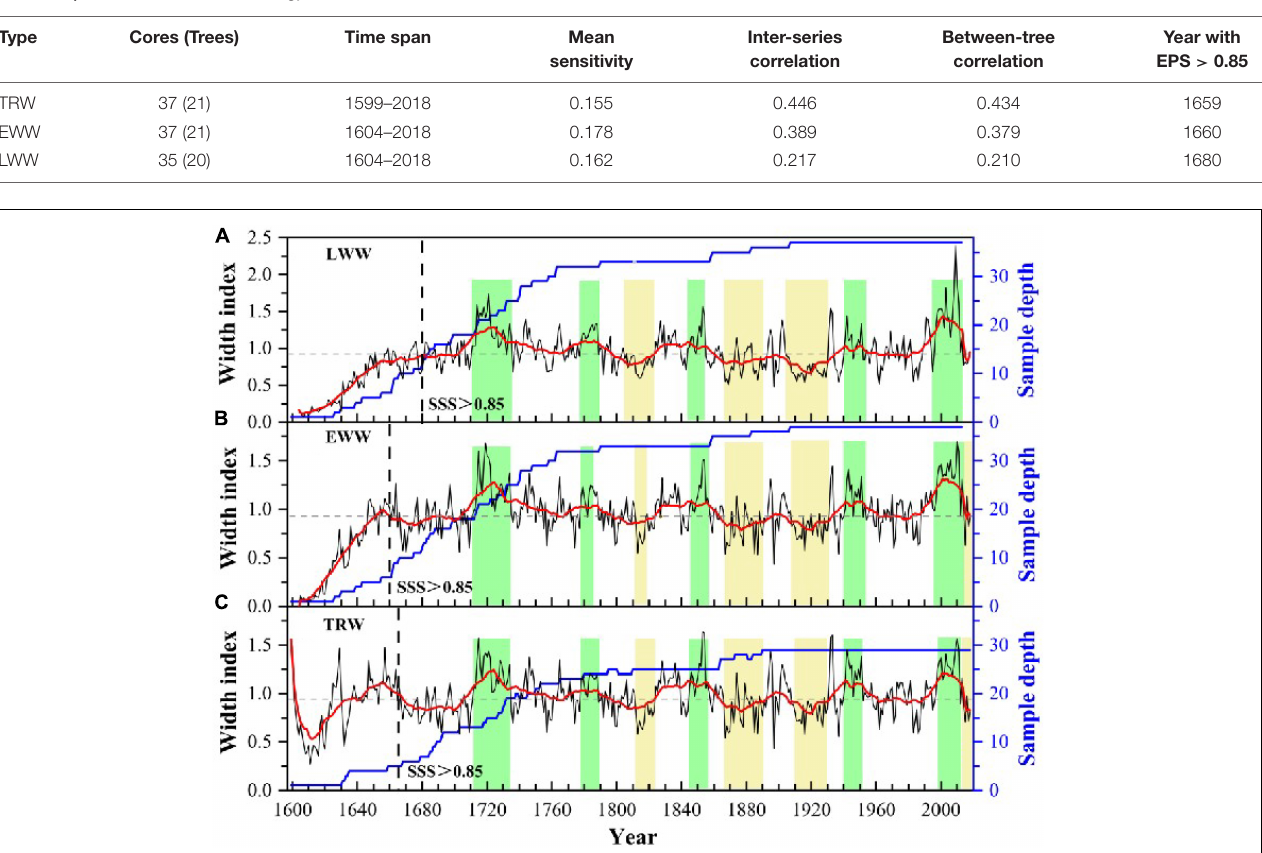
TABLE 1 | Statistics for each chronology at XQDV.